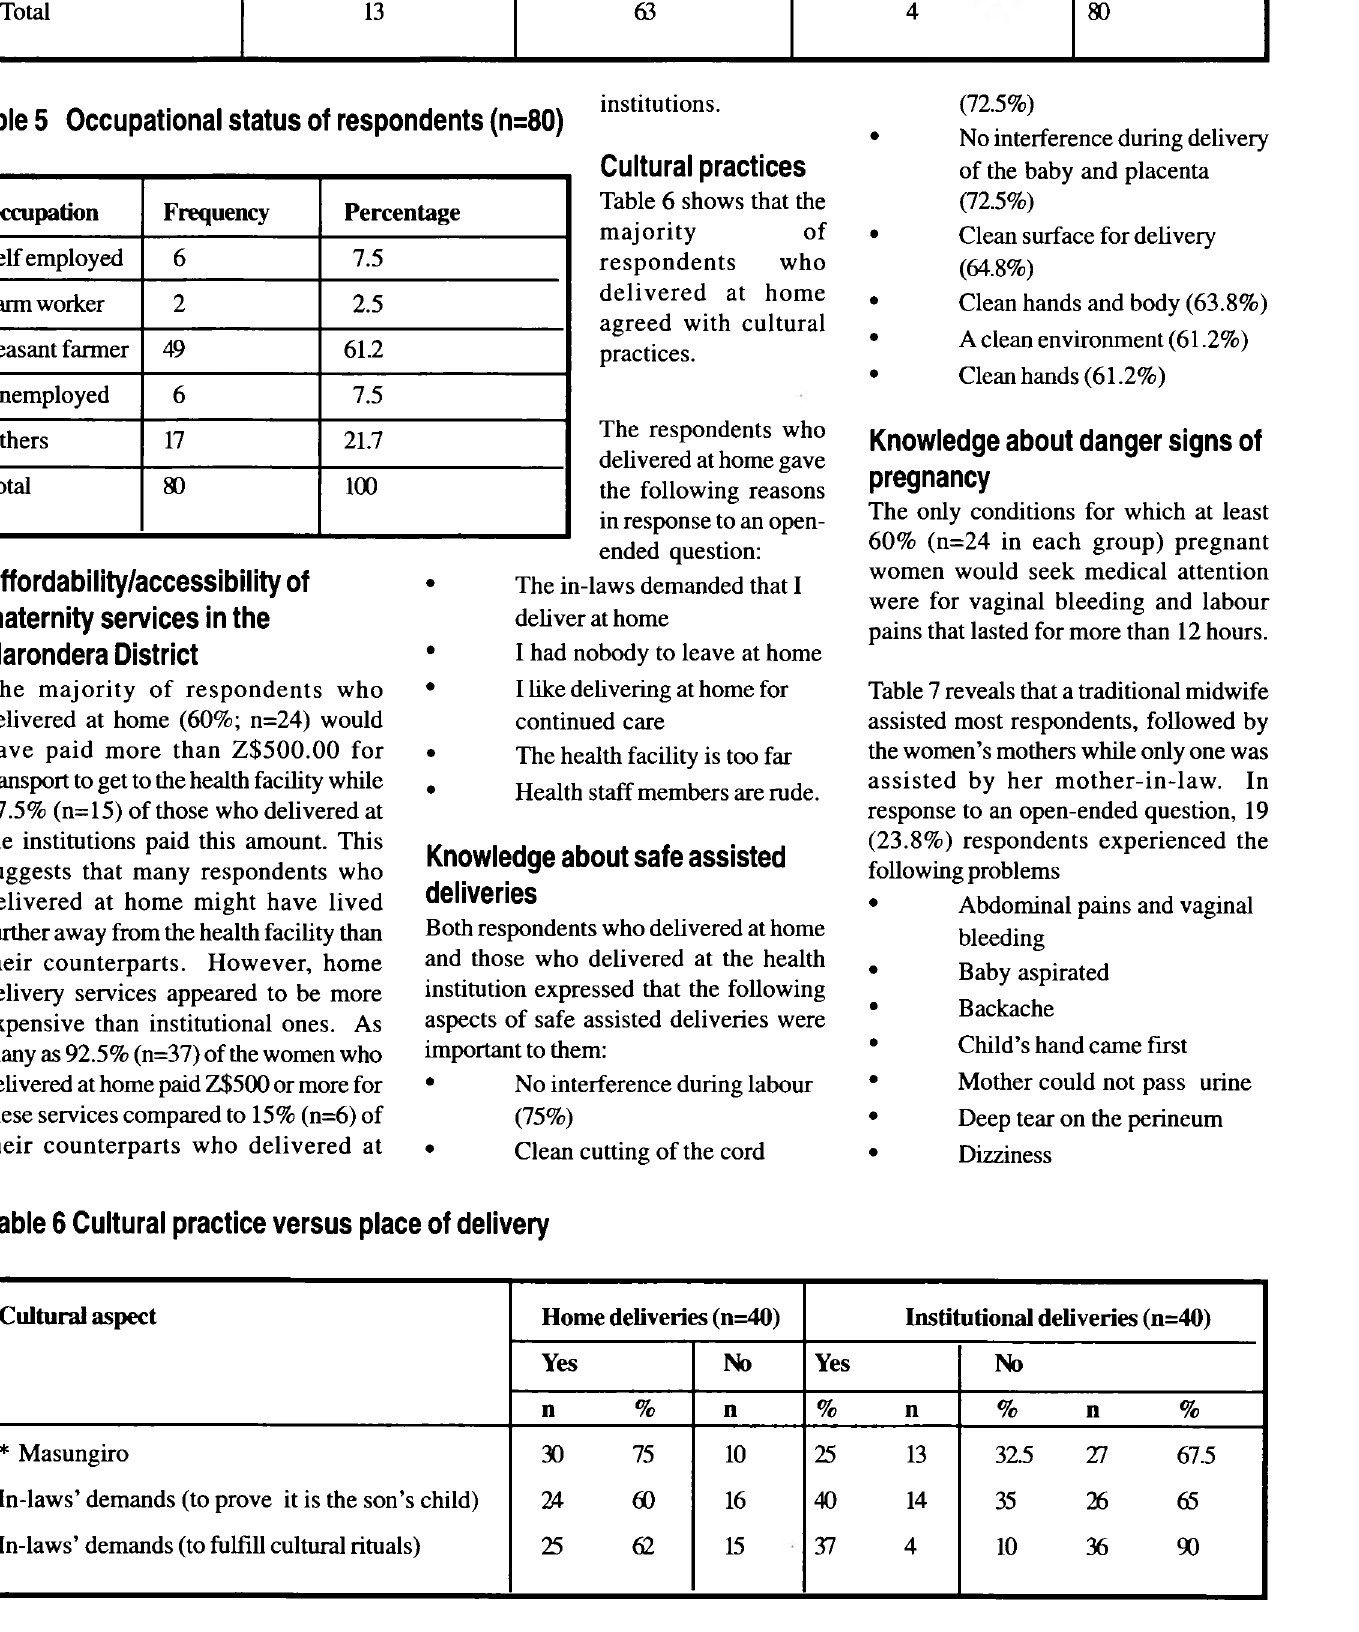
Table 5 Occupational status of respondents (n=80)